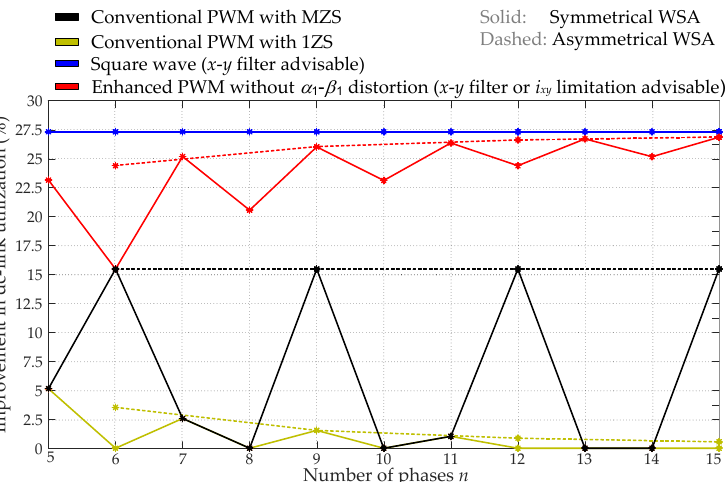
Figure 26. Improvement in dc-link utilization, by various switching techniques, with respect to conventional PWM without zero sequence (i.e., sinusoidal modulating signals)